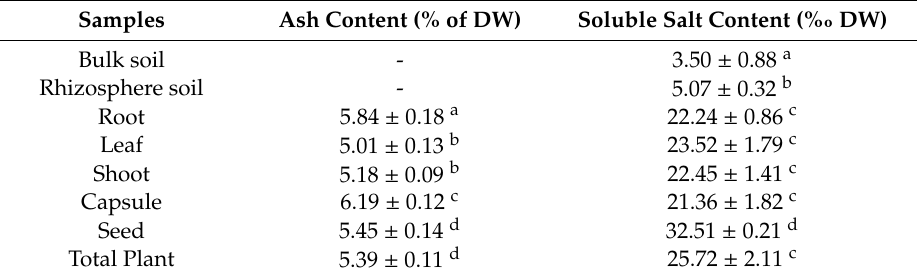
Table 5. The content of soluble salt in di ff erent soil and wild soybean tissue samples.